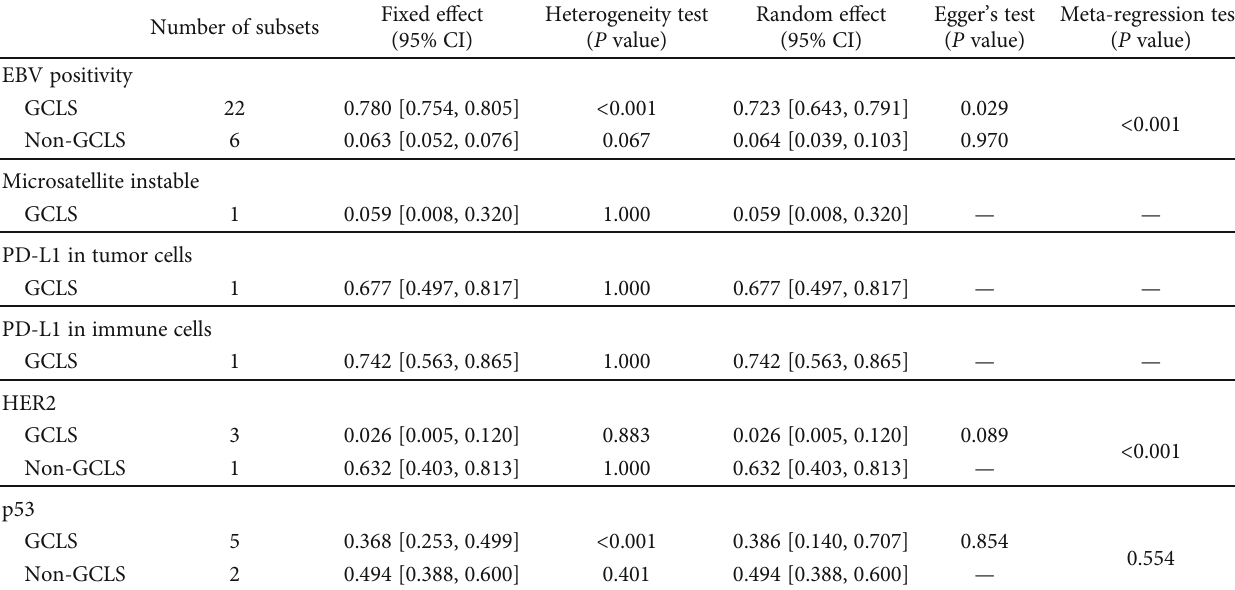
Table 4: The estimated rates of various markers in gastric carcinoma with lymphoid stroma.